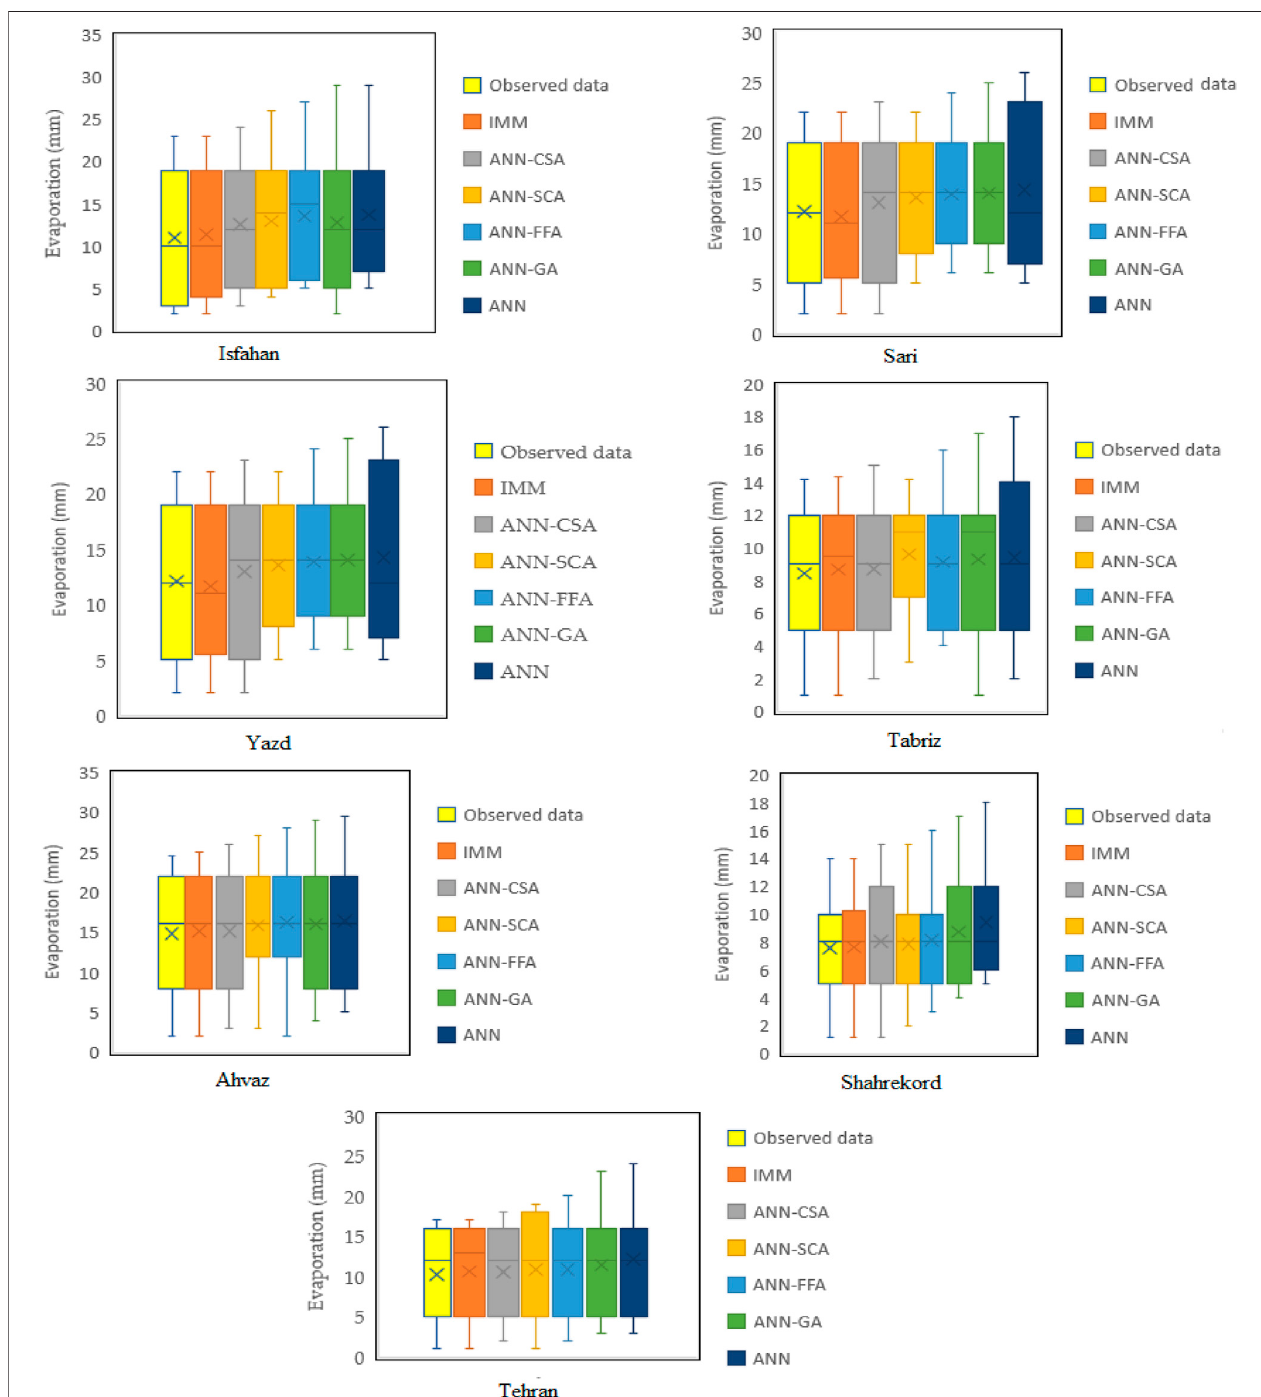
FIGURE 2 | The box plots for the